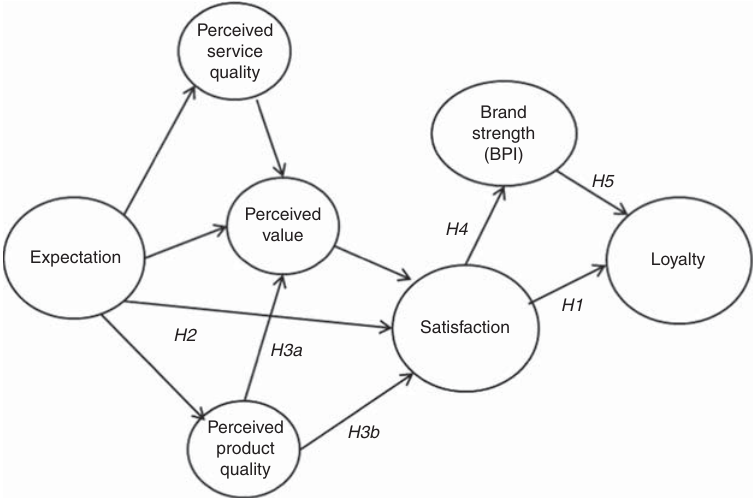
Figure 1. Proposed